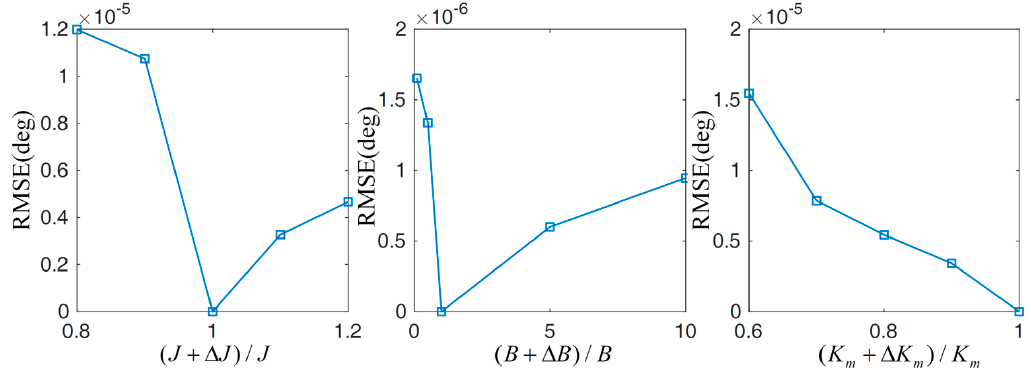
Figure 15. The toolface RMSE in the presence of parameter uncertainties.